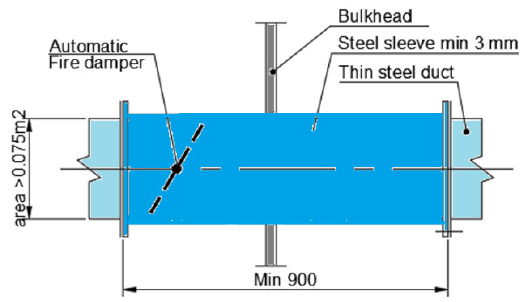
Figure 8. A class fire division—penetration of thin plate ventilation duct, area ≥ 0.075 m 2 . The requirements regarding avoiding flooding through the ventilation system are